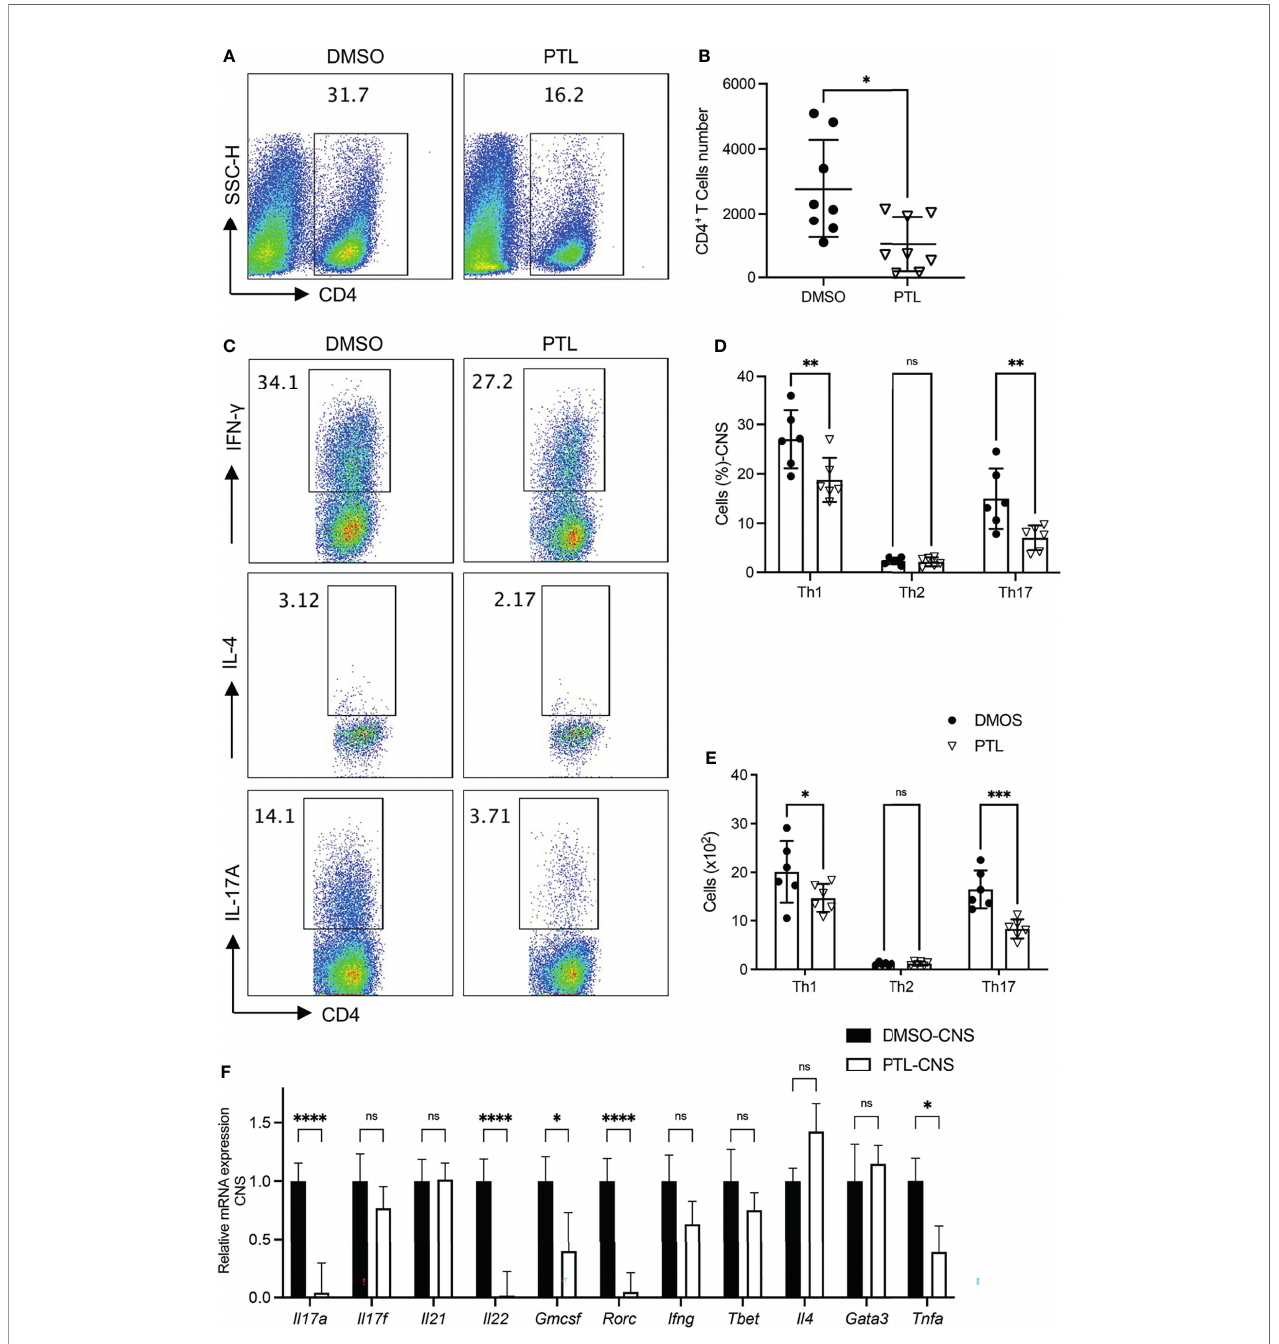
FIGURE 2 | PTL treatment reduced Th1 and Th17 response in CNS of EAE mouse. Cells were isolated from the CNS of EAE mice treated with DMSO or PTL on day 21 after the immunizations and stimulated with PMA/ion plus golgi stop for 5 h (A) Percentage of CD4 + T cell and (B) absolute number of CD4 + T cell in CNS of EAE mice treated with PTL or DMSO ( n = 8). (C, D) Percentage of Th1, Th2, and Th17 cells in CNS of two groups of EAE mice ( n = 5). (E) Cell numbers of Th1, Th2, and Th17 cells in the CNS of two groups of EAE mice. (F) RT-PCR analysis of mRNA expression of Th1, Th2, and Th17 cell-related cytokines and transcription factors, in lymphocytes separated from the CNS of two groups of EAE mice ( n = 3). Data shown are representative of 3 independent experiments. The error bars shown were the mean ± SD. * p < 0.05, ** p < 0.01, ***p < 0.005, ****p < 0.001 using unpaired Student ’ s t -test. ns means “ not signi fi cant ”